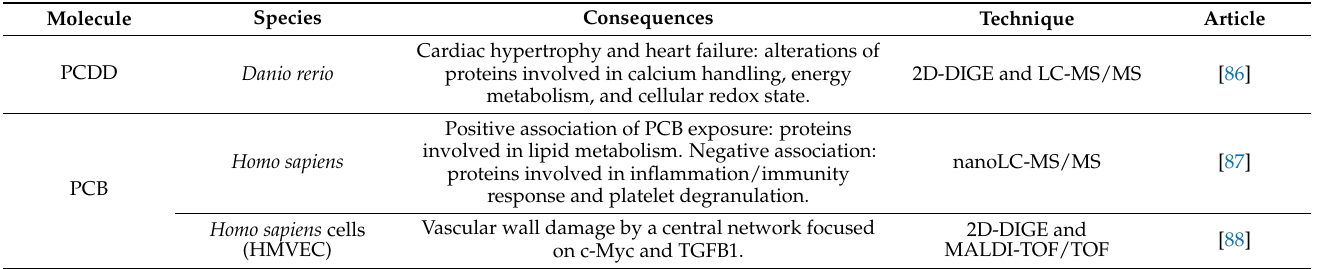
Table 6. Articles describing POP-induced cardiotoxicity.